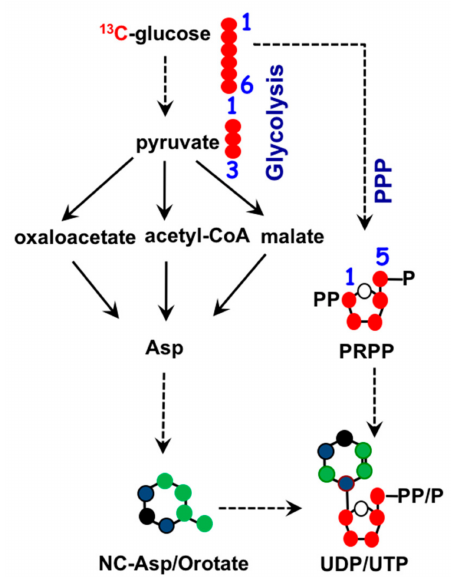
Figure 2. Biochemistry of pyrimidine nucleotide synthesis. Ribose base biosynthesis comes from the pentose phosphate pathway (PPP) in the cytosol. Mitochondrial TCA cycle metabolites oxaloacetate and aspartate (asp) supply three out of the four carbons in the diazine ring. • : Possible cytosolic-derived carbons, • : Possible mitochondrial-derived carbons. • : Nitrogen.